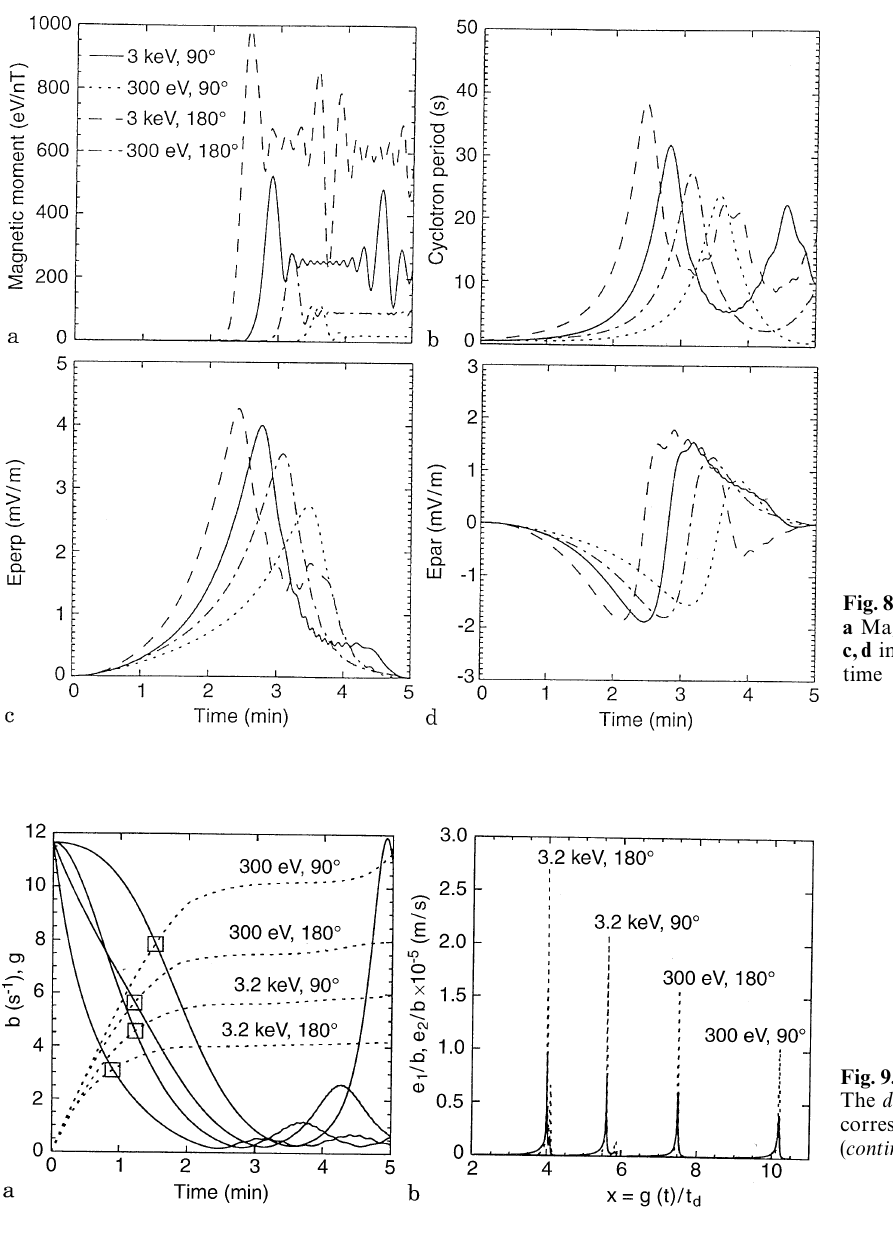
Fig. 9. a b ( t ) " q / mB ( t ), g ( t ) " (cid:58) b ( t ) dt vs time. The dotted curves of g ( t ) are assigned to the corresponding curves of b ( t ) by squares . b e (cid:49) / b ( continuous ), e (cid:50) / b ( dotted ) versus x " g ( t